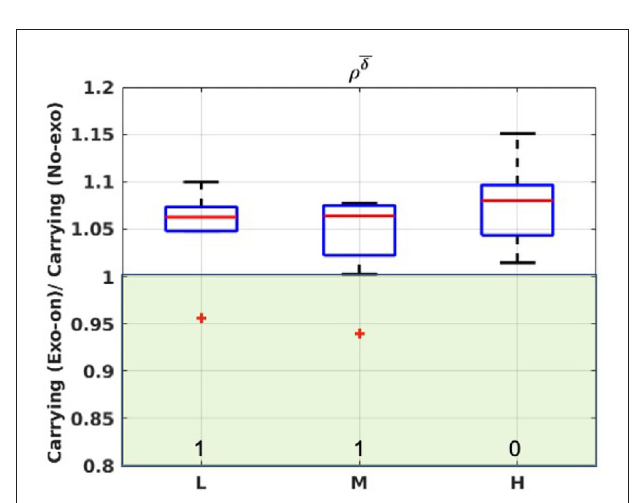
FIGURE 7 | Boxplot representation for ρ δ considering carrying in Exo-on and No-exo condition. L, M, and H refer to the light, medium, or heavy loading condition. Green-shaded areas identify the regions where ρ δ < 1 (i.e., the exoskeleton reduces the stride duration). Numeric values at the bottom of each box report the value of γ